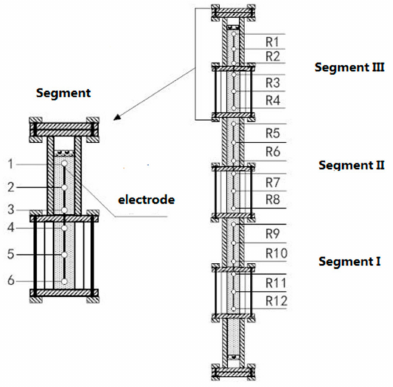
Figure 2. Hydrate-formation